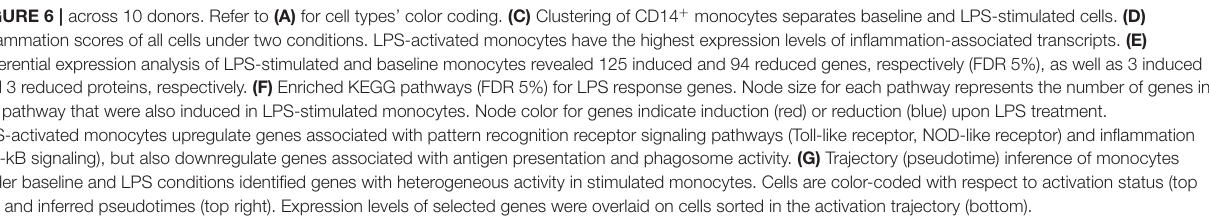
and 47 genes uniquely induced in these states,